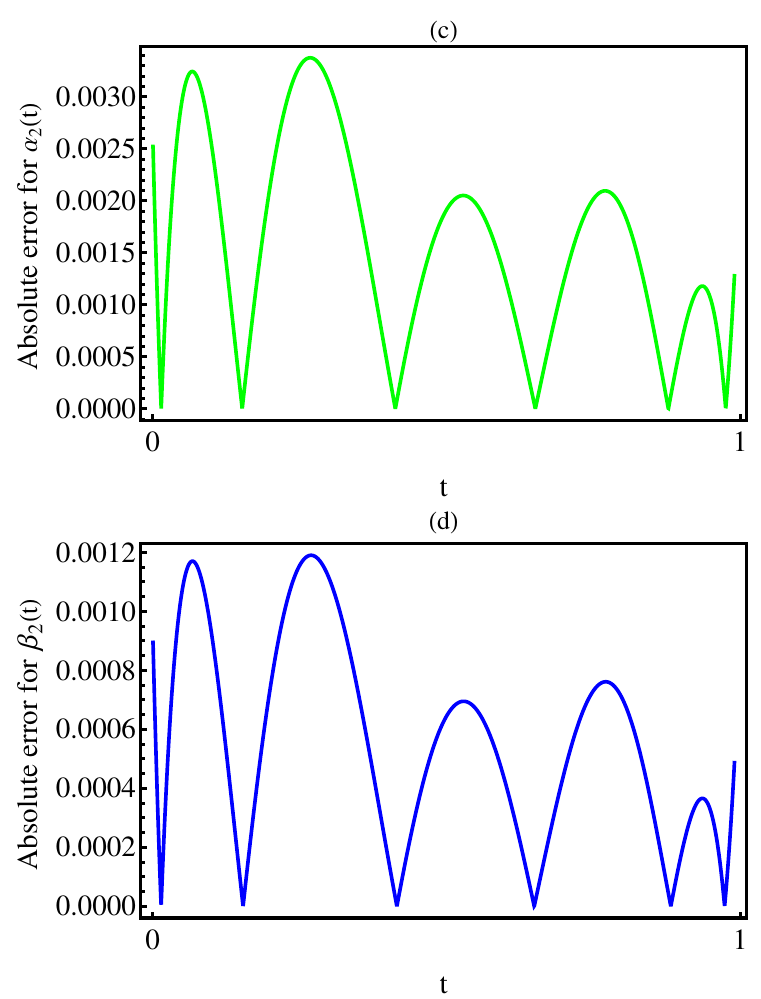
Figure 2. Absolute error between the numerical solutions of Equations (82)–(85) and [24] based on Mittag-Leffler kernel for (cid:36) = 0.9, k = 0.8, δ = 1, γ = 2, σ = 1, and h = 0.0003. ( a ) Absolute error for